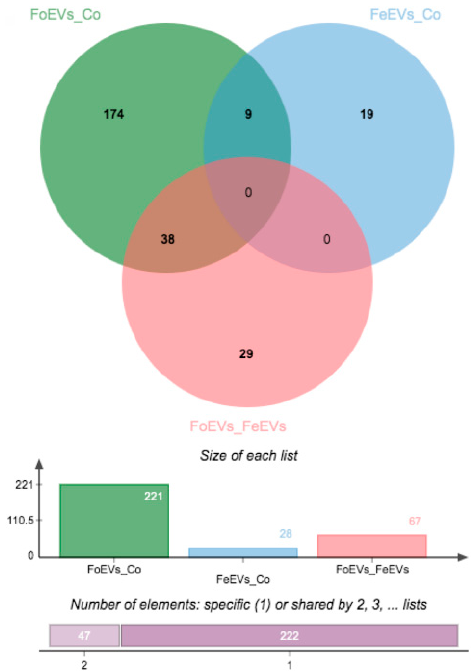
Figure 1. Venn diagrams showing the distribution of differential expressed genes (DEGs) regulated by oviductal extracellular vesicle (oEV) treatments. Data were based on a p -value cut-off of 0.001 and an FDR of 0.05 (FoEV treatment vs. Co). FoEVs_Co: embryos cultured with frozen oEVs (FoEVs) compared to embryos without oEVs (Co, control); FeEVs_Co: embryos cultured with fresh oEVs (FeEVs) compared to Co; FoEVs_FeEVs: FoEVs compared to FeEVs.